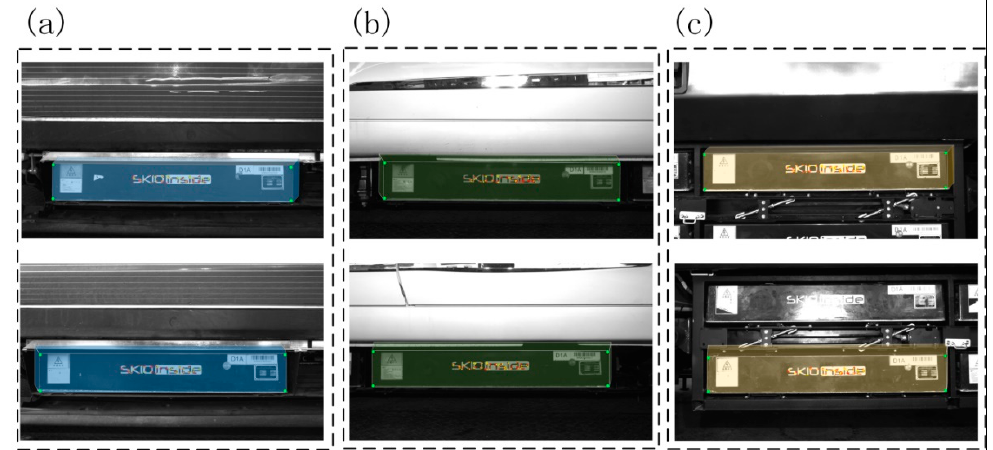
Figure 13. Experimental results of pose estimation for three different electric automobiles with different poses. ( a ) Battery in the minicar; ( b ) Battery in the compact car; ( c ) Battery in the truck.